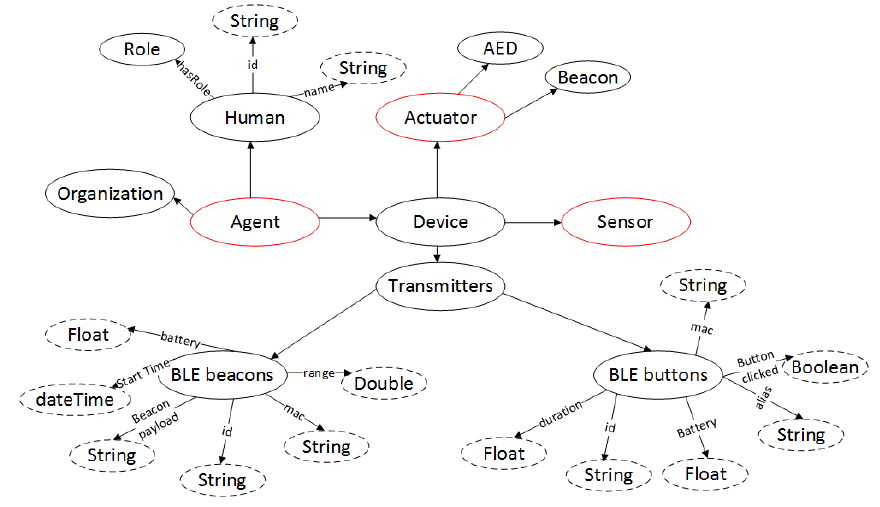
Figure 13. Agent